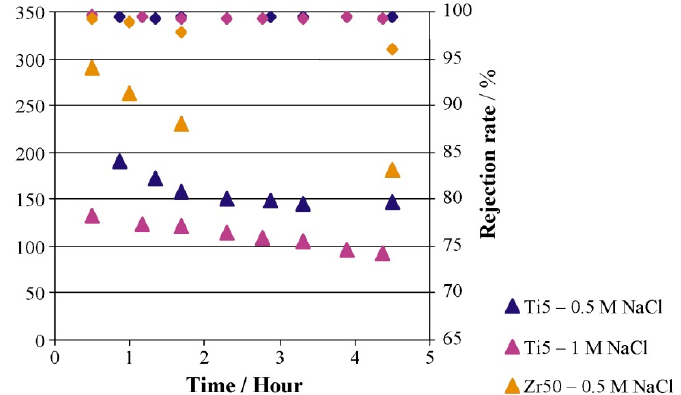
Figure 7. Flux ( ) on left vertical axis and rejection rate ( ● ) on right vertical axis as a function of time in vacuum membrane distillation (VMD) of NaCl solutions (0.5 and 1 M) using Ti5 and Zr50. Feed solution: temperature of 40 °C and atmospheric pressure. Permeate side: room temperature and pressure of 3 mbar [123]. Reproduced with permission from [123].